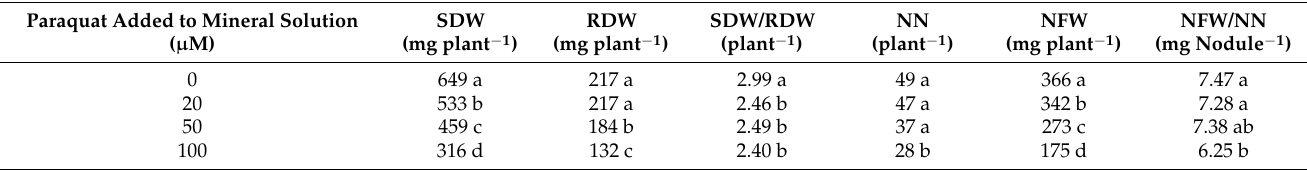
Figure 2. Effect of paraquat addition on B. diazoefficiens 110 spc 4 growth determined by OD 600 nm . Paraquat was added within two ranges of concentration: 0–50 µ M ( a ) and 0–500 µ M ( b ). Data are expressed as the mean and standard deviation of 5 replicates. At each time, asterisk (*) means statistical differences according to the Wilcoxon–Mann–Whitney test ( p ≤ 0.05). Table 3. Effect of paraquat addition on shoot dry weight (SDW), root dry weight (RDW), shoot-to-root ratio (SDW/RDW), nodule number (NN), nodule fresh weight (NFW) and fresh weight per nodule (NFW/NN) of soybean plants inoculated with B. diazoefficiens 100 spc